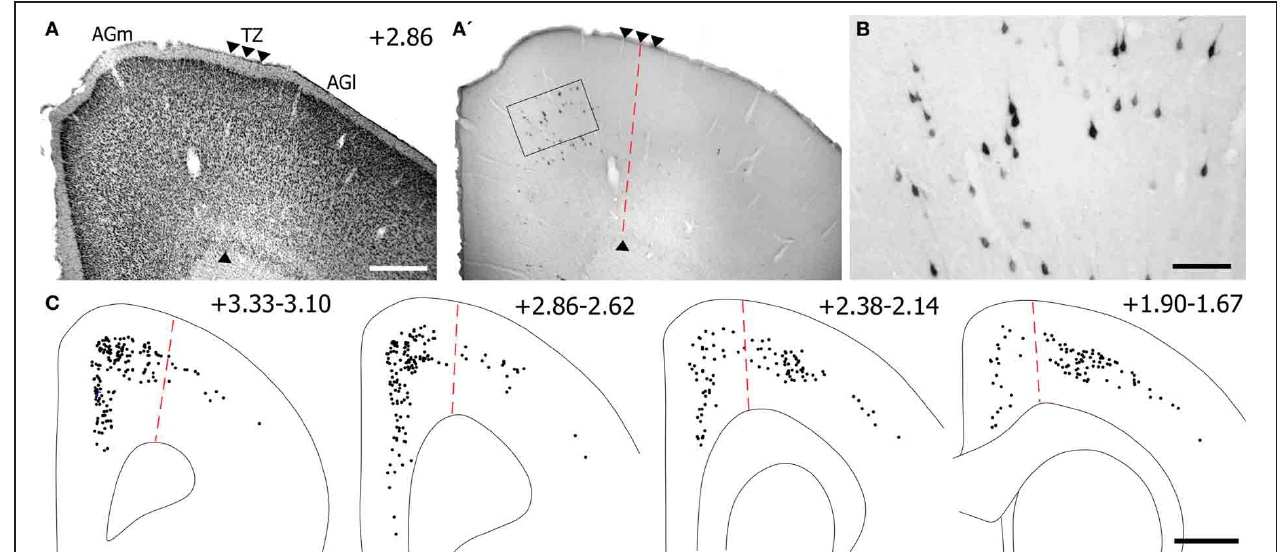
AGm. Rectangle depicts region shown in panel (B) . (C) Digital reconstruction of labeled neurons throughout the rostrocaudal extent of MI. Two plotted reconstructions are superimposed in each depiction. Scale bars = 500 μ m in (A) ; 100 μ m in (B) ; 1mm in (C)